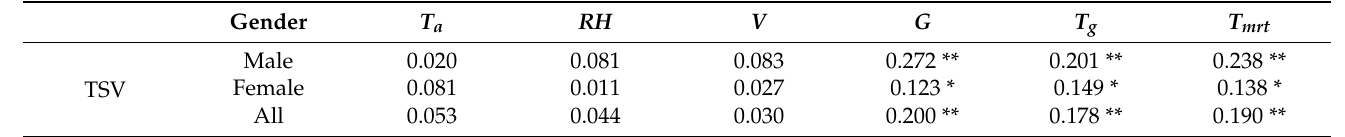
Table 5. Spearman correlation statistics of TSV and meteorological